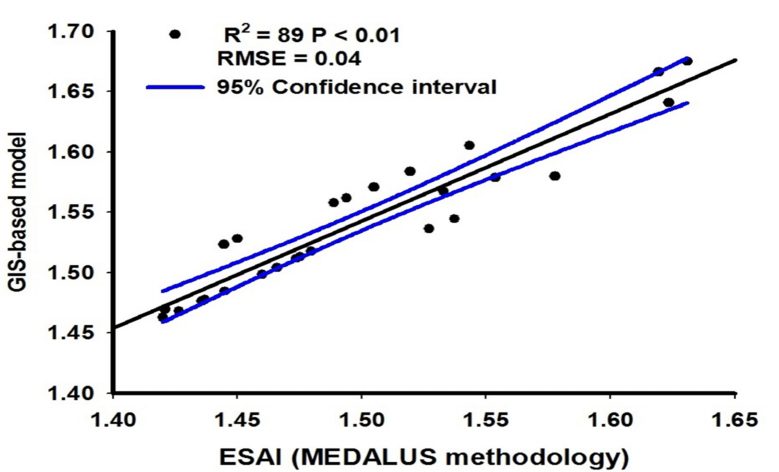
Figure 8. Relationship between the proposed model and ESAI used in MEDALUS methodology.